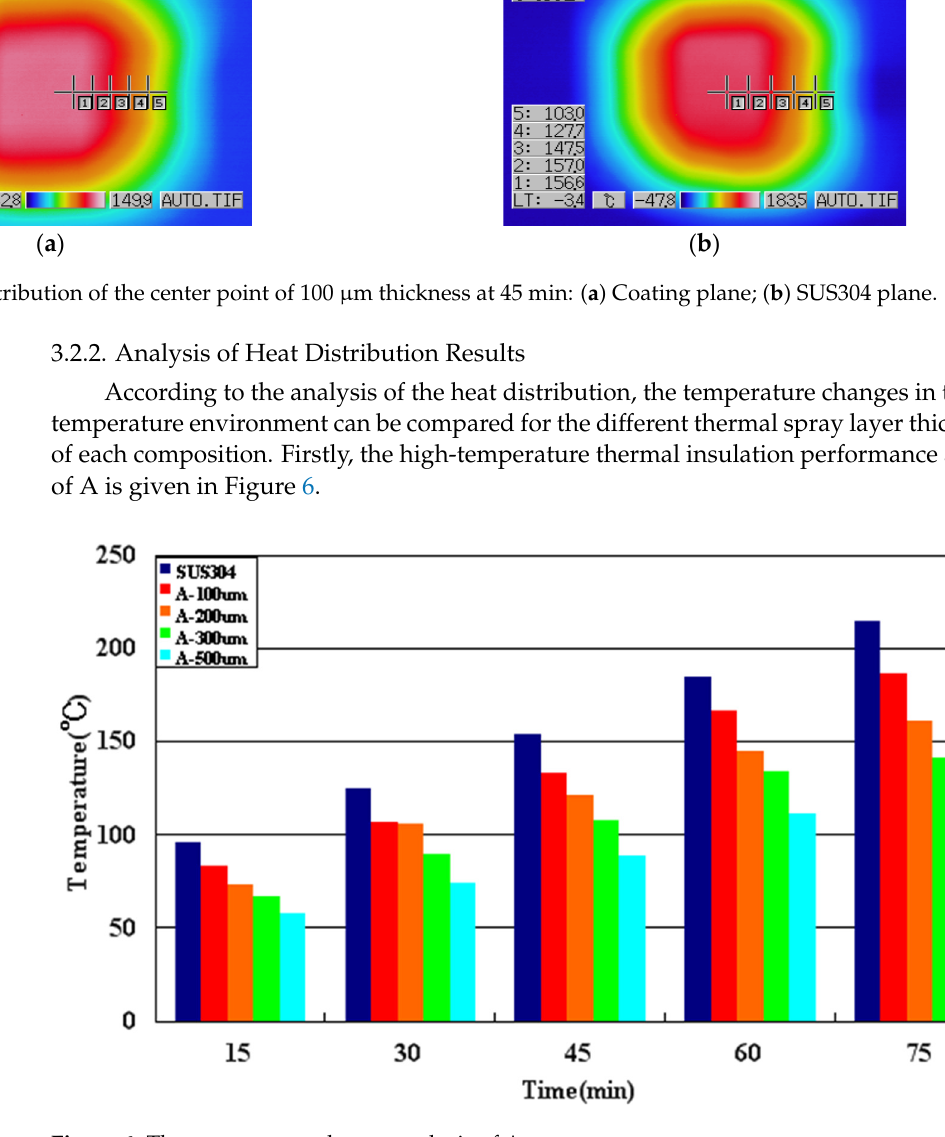
Figure 6. The temperature change analysis of A.